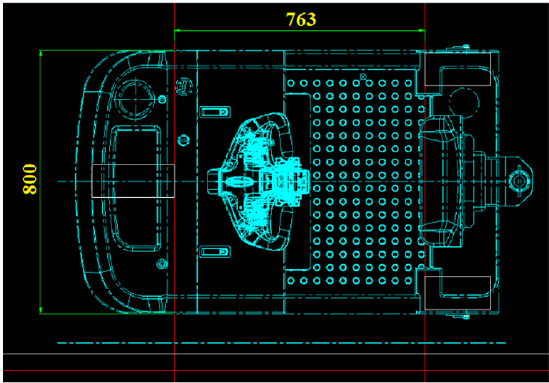
Figure 3. Dimensions of electric forklift chassis (unit: mm).